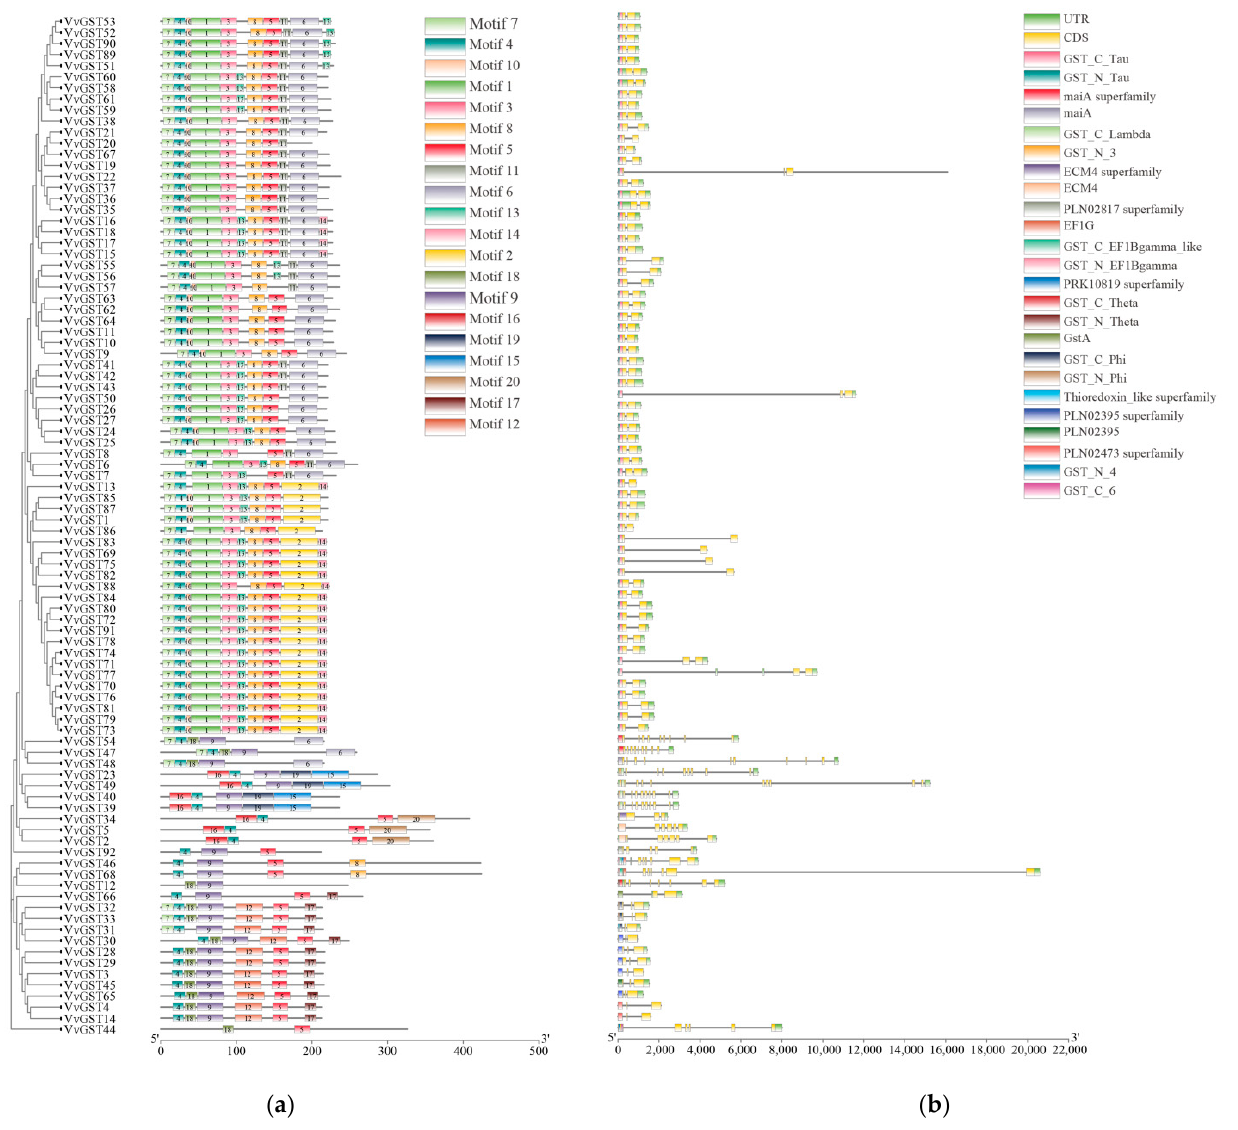
Figure 5. Protein motifs and DNA structures of GST genes family in grapes. ( a ) The protein motifs in the GST members. Different colored boxes indicate different motifs. ( b ) The DNA structures of the GST gene family in grapes. Different colored boxes delineate different structures.